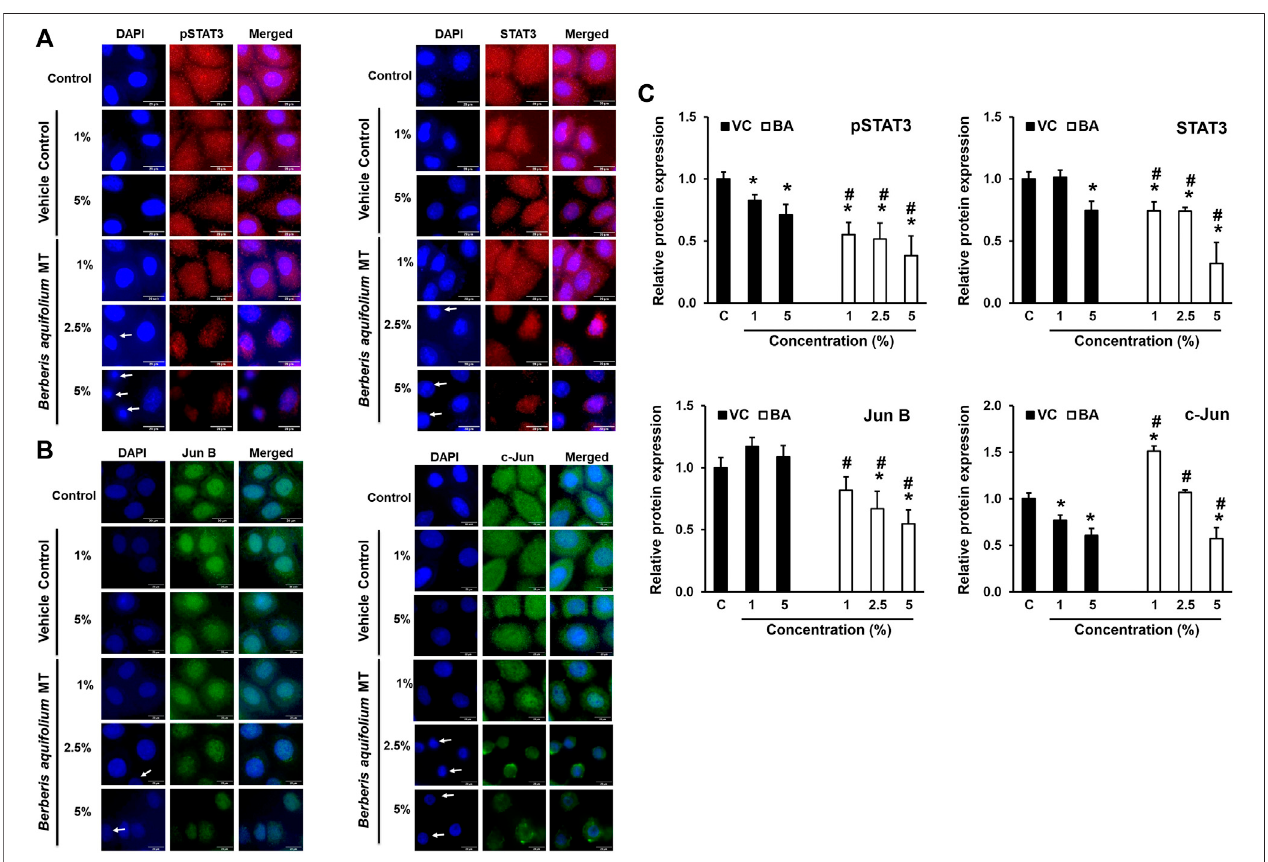
FIGURE 4 | Localization of pSTAT3, STAT3, JunB and c-Jun in BAMT-treated SiHa cells. Representative fl uorescence photomicrographs showing distribution of indicated transcription factors in BAMT-treated and control cells by immunocytochemistry. Cells were fi xed, stained with respective antibodies and detected with goat anti-mouse IgG-Alexa-594 (for pSTAT3Y705 and STAT3; Red; (A) and goat anti-rabbit-IgG-Alexa-488 (Jun B and c-Jun; Green; (B) and counterstained with DAPI (Blue).Arrow indicatesnucleiwithreducedsize.Theexpression levelwasmeasured byImageJandplottedasmean ± SEMoftherepresentativeexperimentoutof threeindependentexperiments (C) .Valueswereobtainedbyanalyzingatleast30cellsperspecimen.* p value < 0.05vs.control. # p value < 0.05vs.vehiclecontrol(VC).